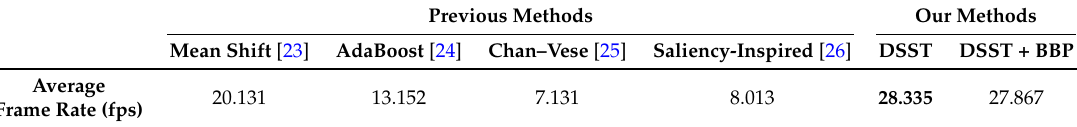
Table 6. Average frame rate of the tracking algorithms.